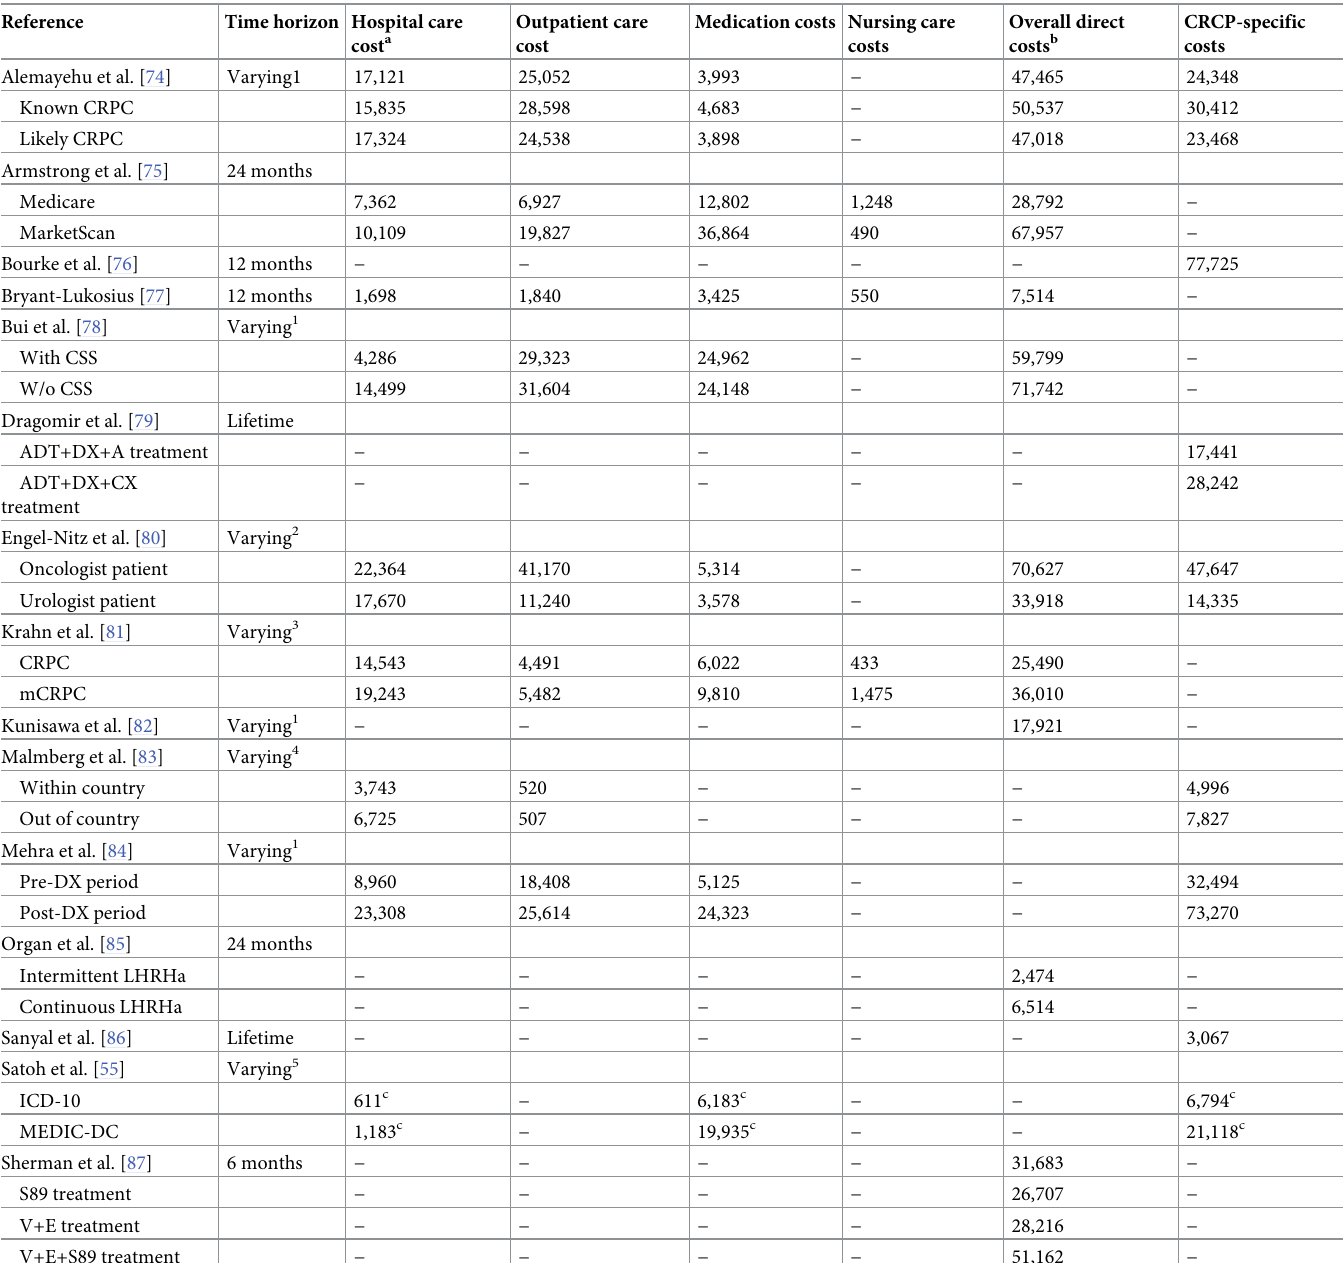
Table 4. Cost-of-illness analyses–Costs in categories and total costs per patient per year (in 2015